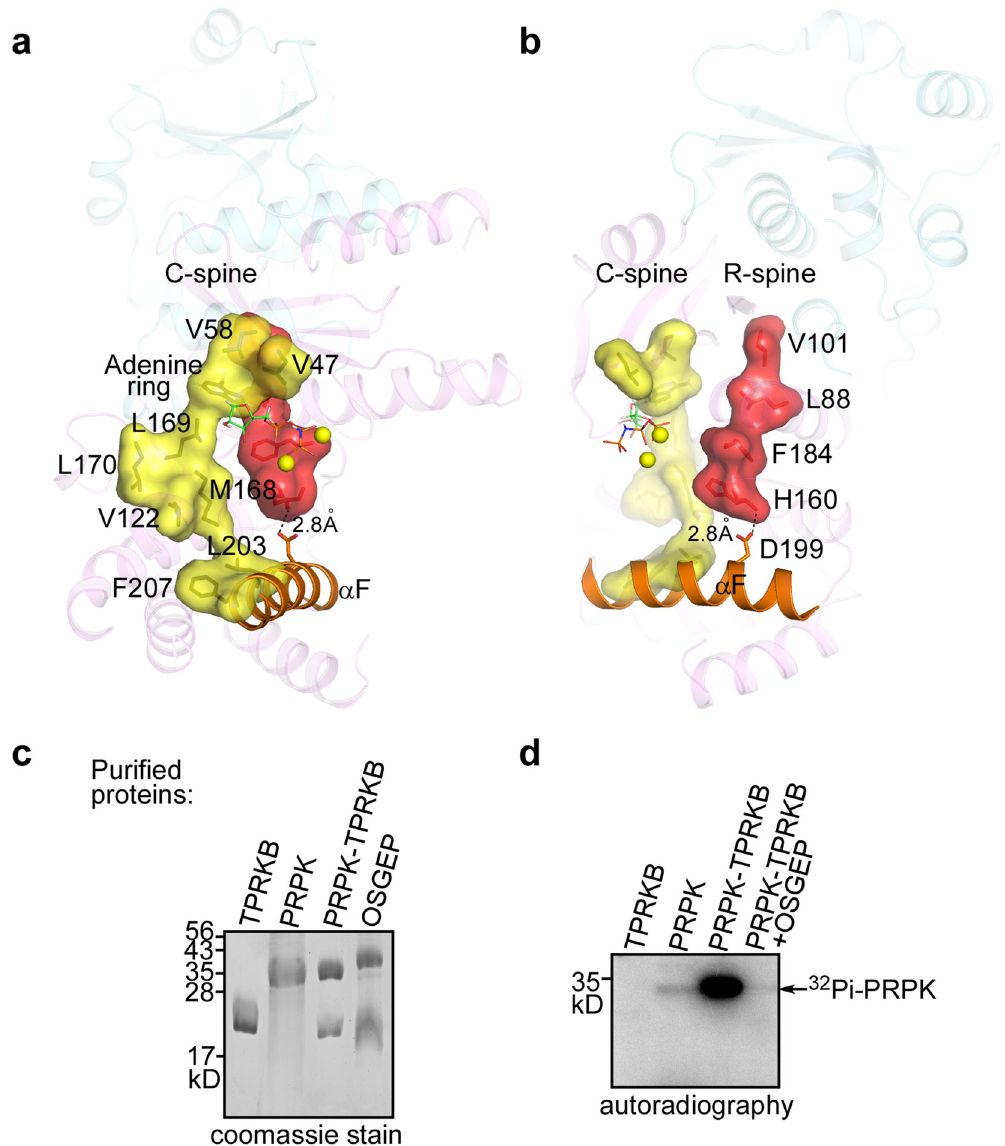
Fig. 3 Two spines of PRPK. a The catalytic spine (C-spine) is formed by V47, V58, adenine ring of AMPPNP, L169, L170, M168, V122, L203, and F207 (from top to bottom), and it is directly anchored to the carboxyl end of the helix α F. The C-spine is well assembled. b The regulatory spine (R-spine) is formed by V101, L88, F184, and H160, and it is anchored to helix α F by a hydrogen bond between the D199 carboxyl O atom and – NH group of H160 (dashed line). The R-spine is also well organized and F184 of the DFG loop adopts an active DFG-in conformation. c Puri fi ed proteins used in the kinase assay. d In vitro kinase assay showing the regulation of PRPK autophosphorylation activity by TPRKB and OSGEP. Uncropped images of gel and autoradiograph are shown in Supplementary Fig.